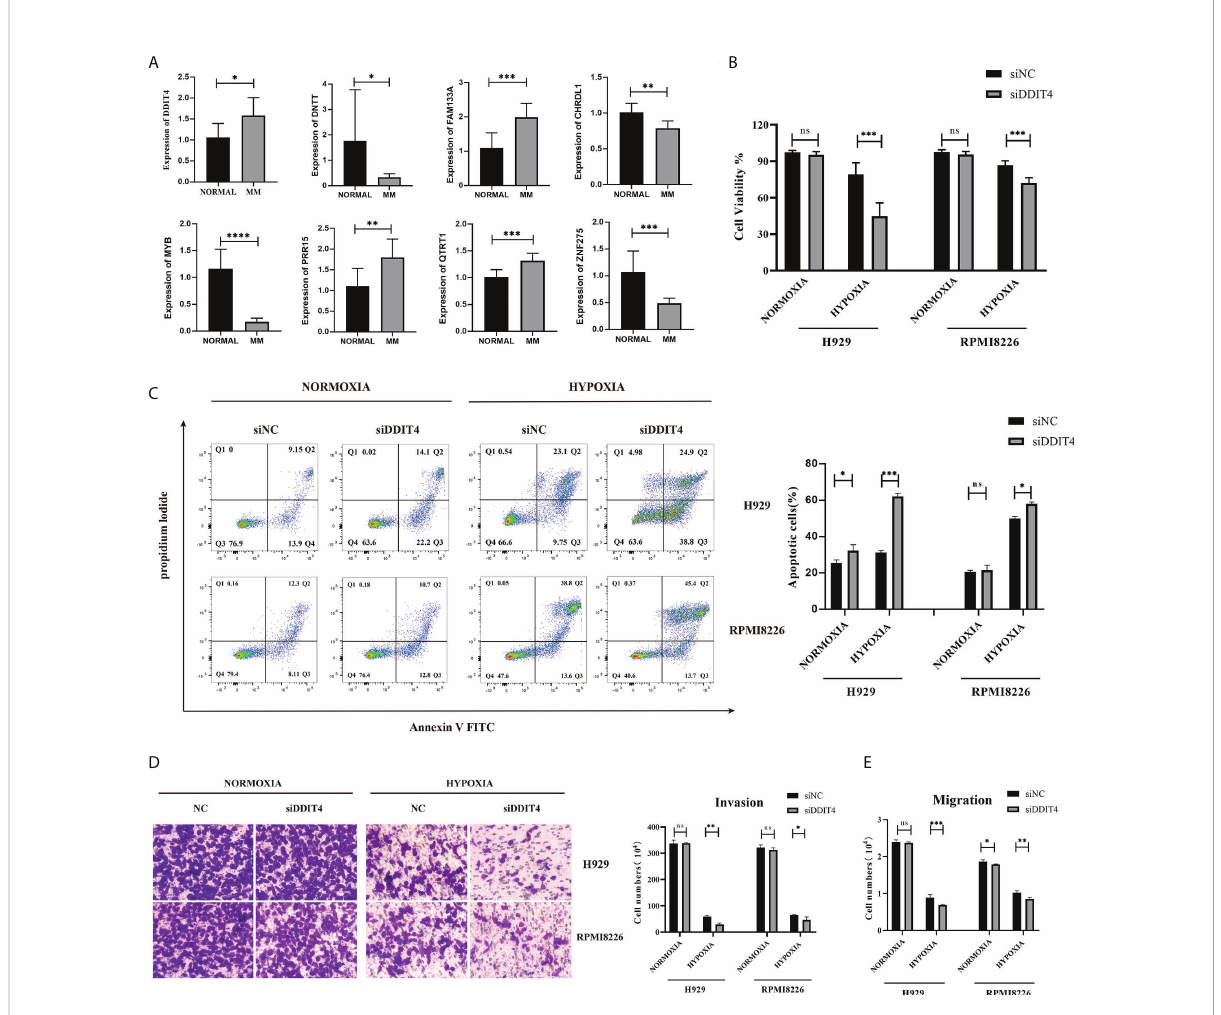
FIGURE 6 Validation of the expression of the 8-gene signature. The gene expression levels of CHRDL1, DDIT4, DNTT, FAM133A, MYB, PRR15, QTRT1 and ZNF275 between normal and bone marrow from 9 MM patients and peripheral blood samples from 7 control patients. (A) The relative expression levels of the 8 genes compared with GAPDH in normal (n = 7) and RRMM (n = 9) samples (*, p< 0.05; **, p< 0.01; ***, p< 0.001; ****, p< 0.0001). (B) The knockdown of DDIT4 reduced the cell viability of two myeloma cell lines relative. (C) The knockdown of DDIT4 increased the apoptosis rate of two myeloma cell lines. (D, E) Invasion and migration ratio of MM cells toward four groups through Transwell membranes (5- m m pore size) were assessed. Independent experiments were performed 3 times. n = 5 per group (**, p< 0.01; ***, p< 0.001; vs. CONTROL; ns, no signi fi